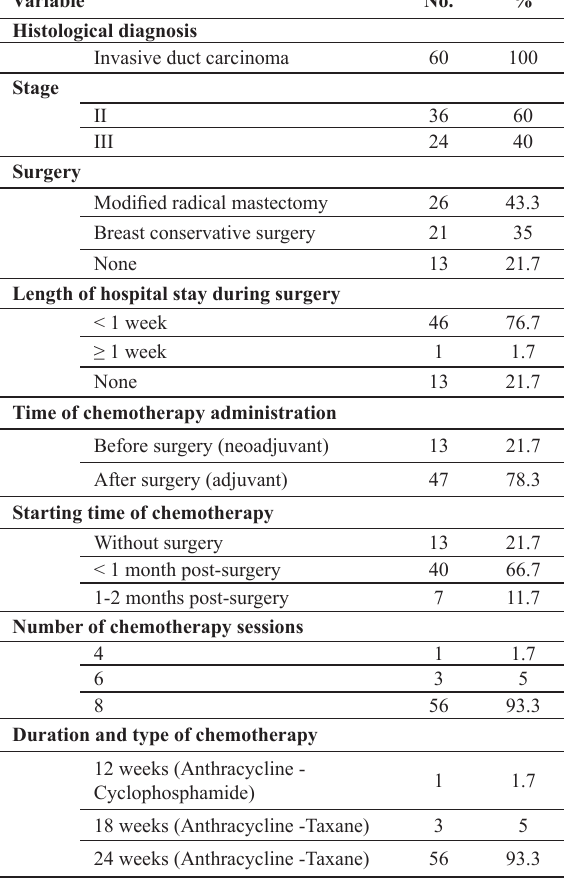
Table 2: Disease characteristics and